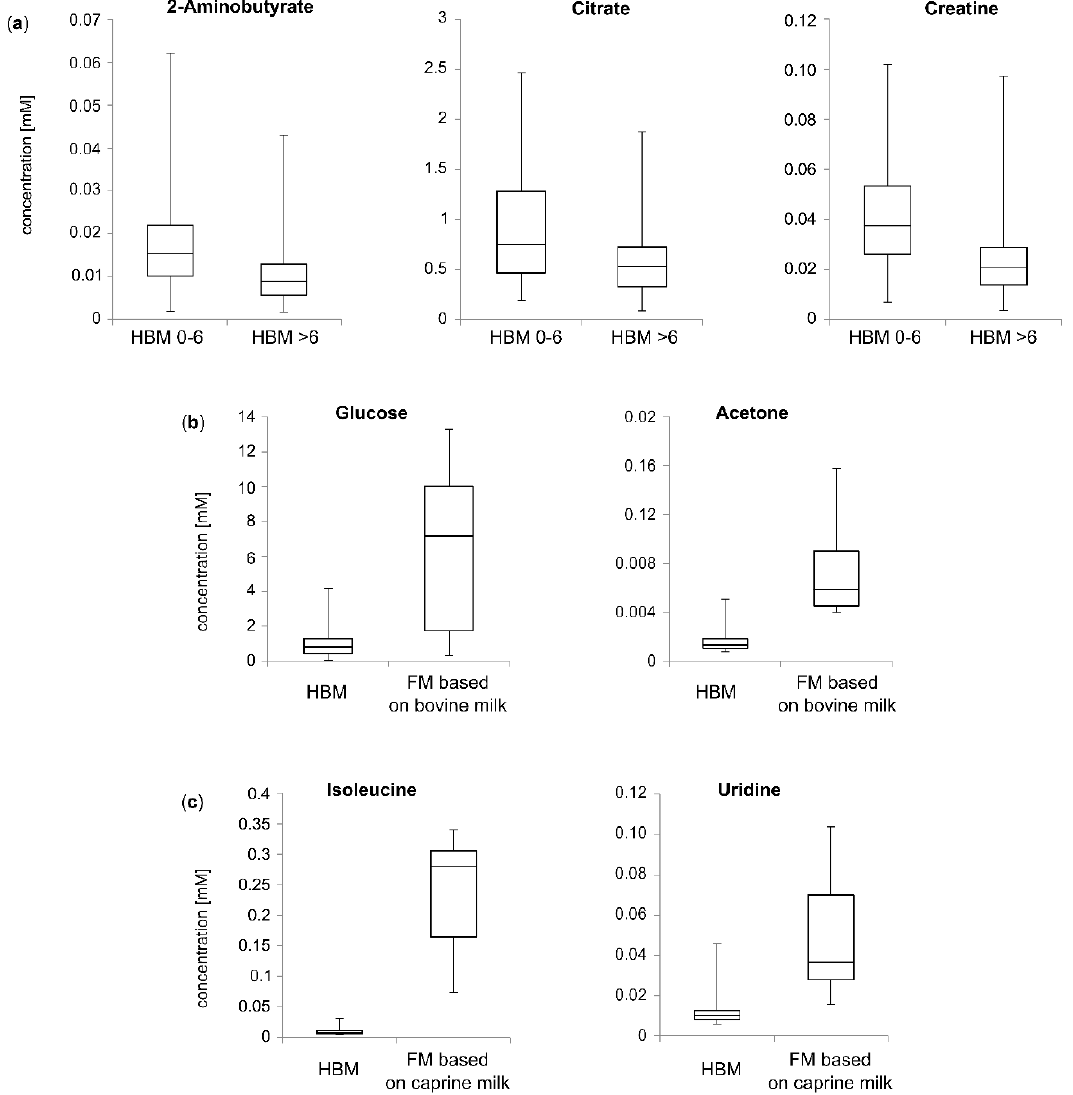
Figure 3 . Box plots showing the distribution of polar metabolites indicated as statistically significantly different between analyzed samples: (a) 2- aminobutyrate, citrate, creatine in HBM samples; (b) glucose and acetone in HBM and formula milk (FM ) based on bovine milk samples; and (c) isoleucine and uridine in HBM and FM based on caprine milk samples. Horizontal lines indicate medians, boxes specify interquartile range and vertical lines denote the ranges. The comparison was made using the Mann –Whitney U test.